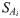
Binding mode landscape for p53 interactions.The oligomerisation domain (residues 325–356, blue squares) exhibits a strong preference for disorder-to-order transitions and forms stable tetramers (PDB:1c26) [36] and higher-order structures. Short linear peptides (residues 378–386, orange diamonds) at the disordered C-terminal regulatory region interact with sirtuin (PDB: 4zzj [37]) and the cyclin dependent kinase cyclin A (PDB:1h26 [38]) exhibit heterogeneous binding modes. On the top of the binding mode landscape two context-sensitive regions are shown. The disordered N-terminal transactivation region interacts with Mdm2 (PDB:1ycr [58]) via a short helical segment (19–25 aa, lime dots). The beginning of the disordered C-terminal region folds into an α-helical conformation (residues 278–285, green dots) to recognise DNA via a variety of dynamic binding modes (PDB: 2ady, [36]). The high SAi values for both regions indicate fuzzy interactions, which are strongly influenced by the cellular context. The interaction sites are shown by the same colours as interaction modes, and partner proteins are displayed by grey surfaces.